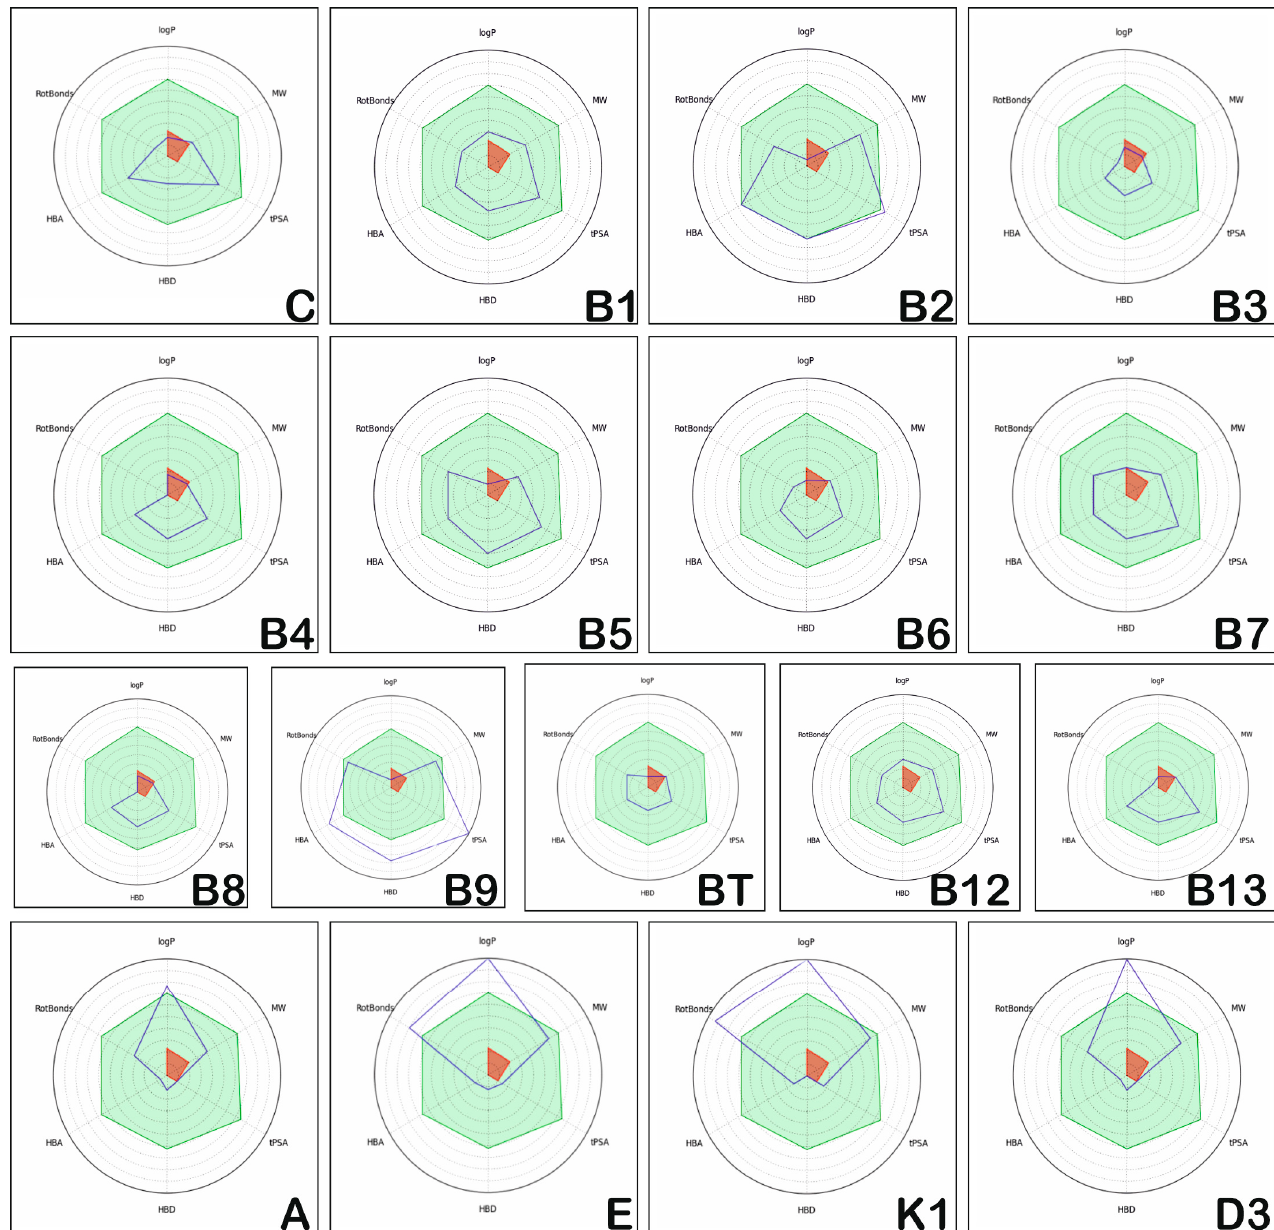
Figure 5. Estimation of oral absorption of the hydrosoluble and liposoluble vitamins. Figure 5 illustrates that vitamins C, B1, B2, B3, B4, B5, B6, B7, B12, BT, B13, and A have almost all of their physico-chemical properties situated in the optimal regions, and as such reflect good oral absorption. Vitamins B9, K1, E, and D3 have numerous properties outside of the optimal area and reflect low oral absorption. Vitamins A and D3 have logP higher than normal, and vit E and K1 have both logP and RotBonds higher than normal, while Vitamin B9 has HBA, HBD, tPSA much higher than normal. On the contrary, vitamins C, B2, B5, B6, B3, B4, B8, BT and B13 have values in the restricted area, with logP much smaller than normal. Vitamin BT and B13 are at the limit in terms of MW, while vitamin B3 has a lower MW and B4 and B8 have logP, RotBonds, and MW lower than normal, situated in the restricted area.